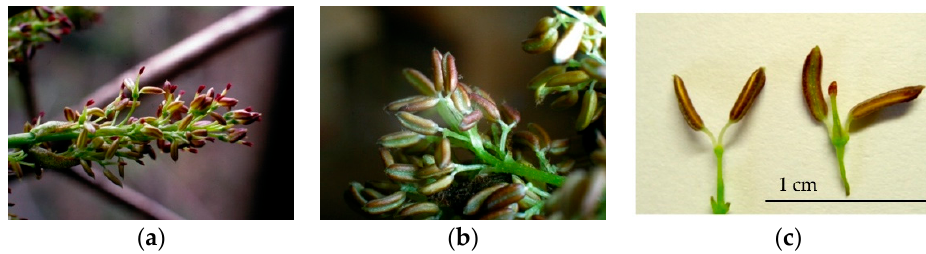
Figure 3. Flower types of Fraxinus platypoda . ( a , b ) Inflorescences of andromonoecious ( a ) and male ( b ) trees. ( c ) Male (left) and hermaphroditic (right) flowers.